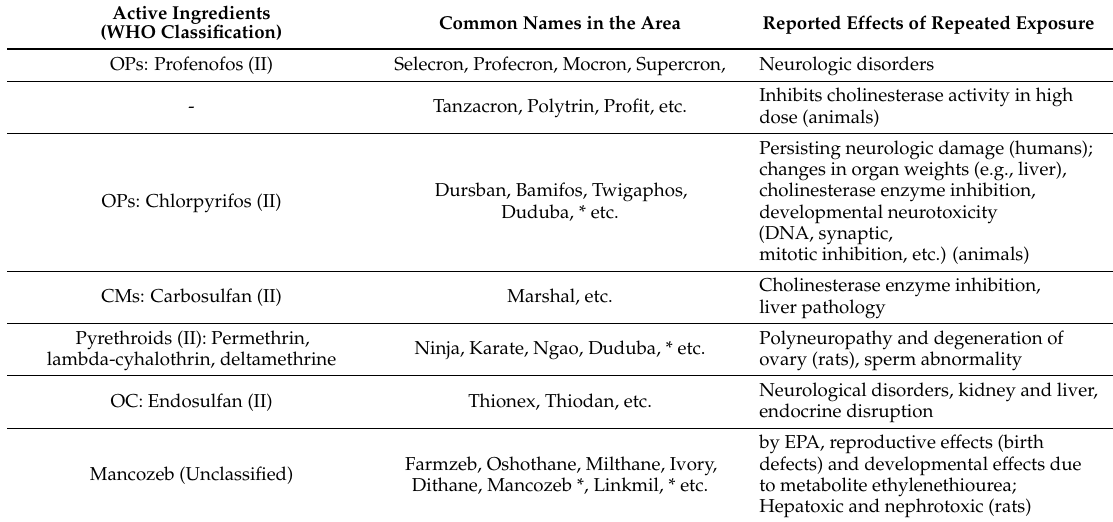
Table 2. Pesticides commonly used in the study area (Arusha region, Tanzania) and the long-term neurological and hepato-nephrotoxic adverse effects reported in animal and/or human